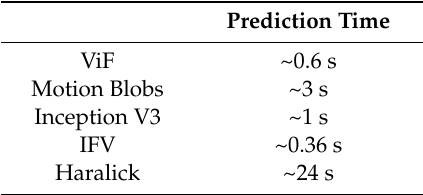
Table 5. Average classification time for implemented